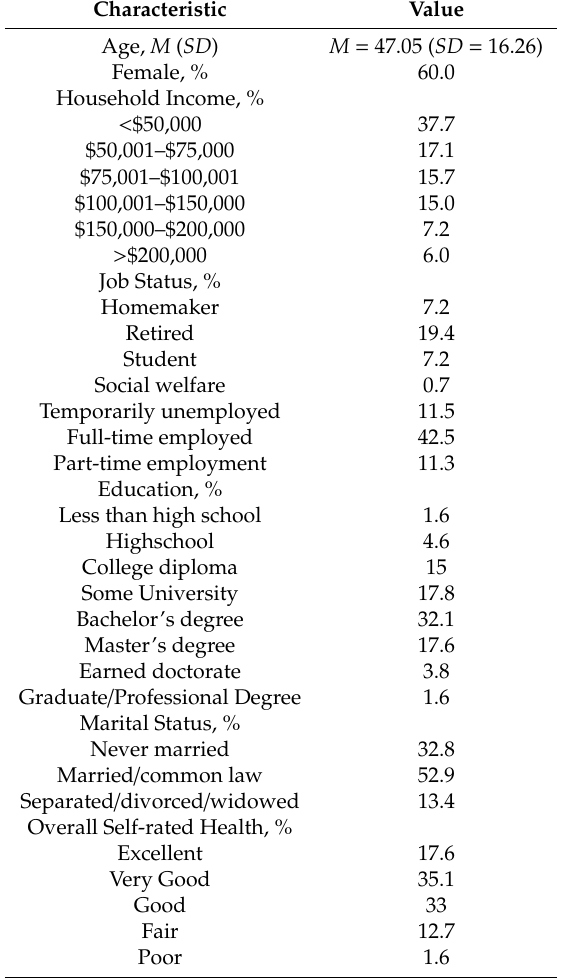
Table 2. Demographic characteristics of the sample.